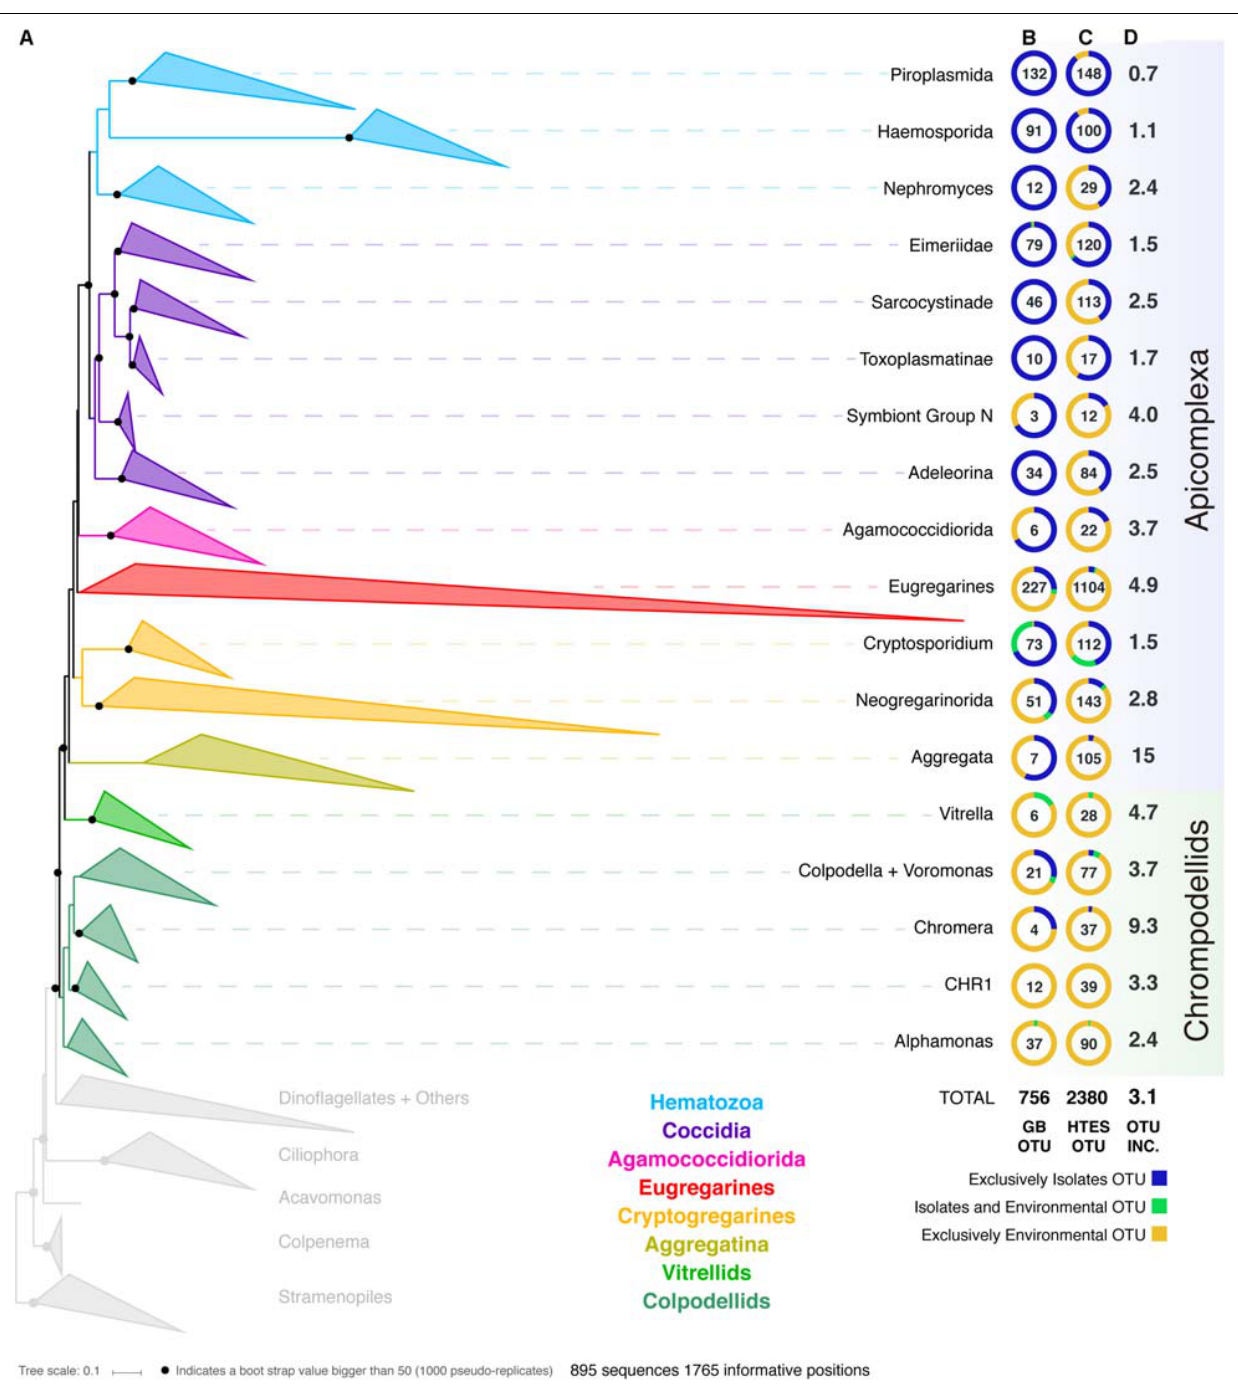
FIGURE 1 | (A) Apicomplexan reference tree inferred from a maximum-likelihood (RAxML) phylogenetic tree constructed (best tree of 1000) using 18S rRNA sequences. Black dots represent bootstrap values > 50% (1000 bootstrap replicates). The tree has been collapsed in the main apicomplexan groups based on our taxonomic annotation ( Supplementary Table S1 ). The tree showing all the OTUs (97% similarity clustering) is available as Supplementary Information S1 . The first two columns next to the Apicomplexan groups’ names inform about the origin (colored circle) and the number of OTUs (number in the middle of the